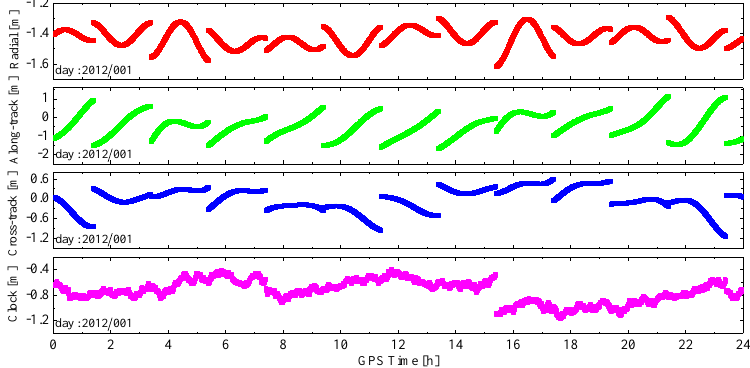
Figure 1. The position and clock offset error of broadcast ephemeris for GPS satellite PRN04.